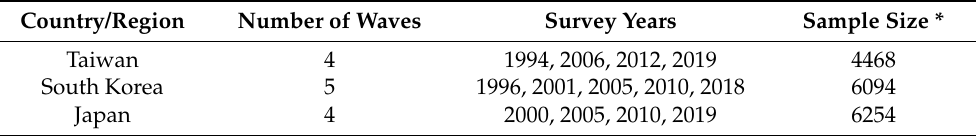
Table 1. Data Set